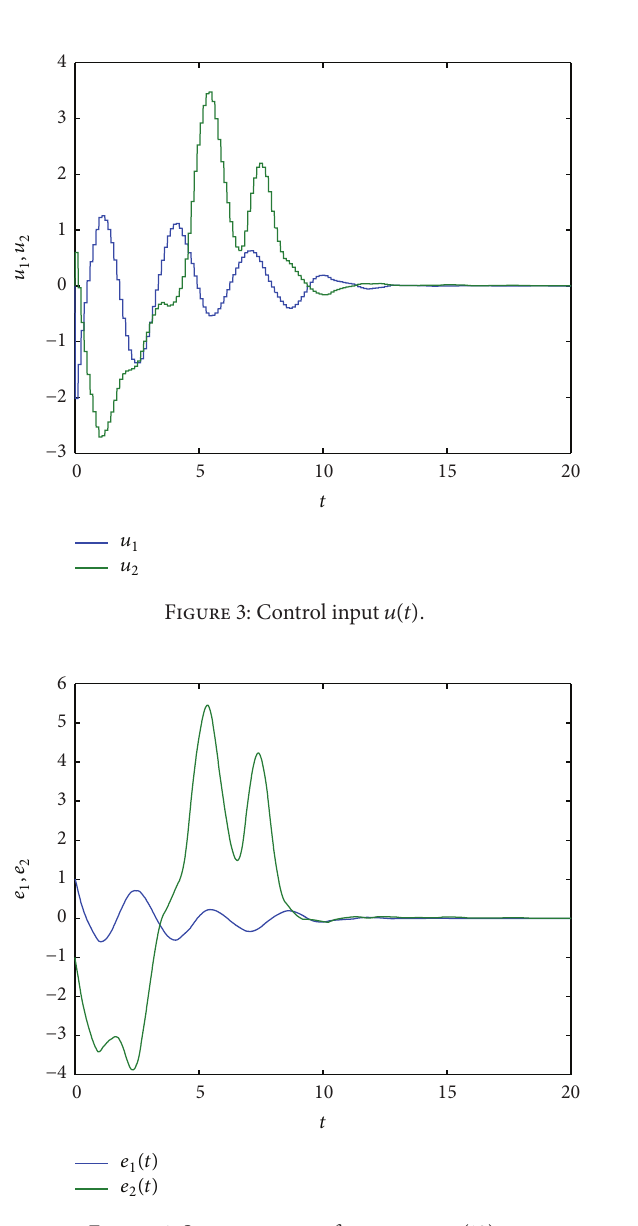
Figure 4: State responses of error system